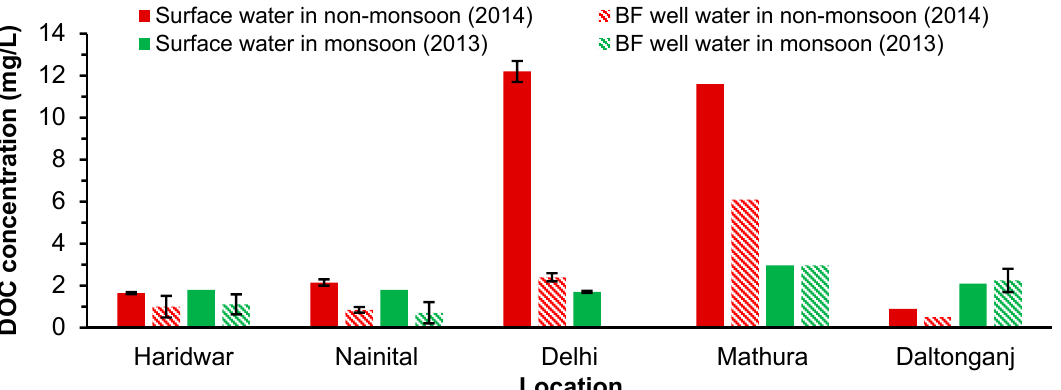
Figure 2. Median dissolved organic carbon (DOC) concentrations in surface water and bank filtration wells at selected sites, except for the RBF wells in Delhi, where no samples were collected in monsoon (2013). Error bars indicate the standard deviation for numbers of samples ( n m : Monsoon; n nm : Non-monsoon) ≥ 2. Haridwar: Ganga, n m = 1, n nm = 2; RBF, n m = 9, n nm = 13; Nainital: Naini Lake, n m = 1, n nm = 2; BF, n m = 3, n nm = 6; Delhi: Yamuna, n m = 2, n nm = 2; RBF, n nm = 5; Mathura: Yamuna, n m = 1, n nm = 1; RBF, n m = 1, n nm = 1; Daltonganj: North Koel, n m = 1, n nm = 1; RBF, n m = 2, n nm = 1.